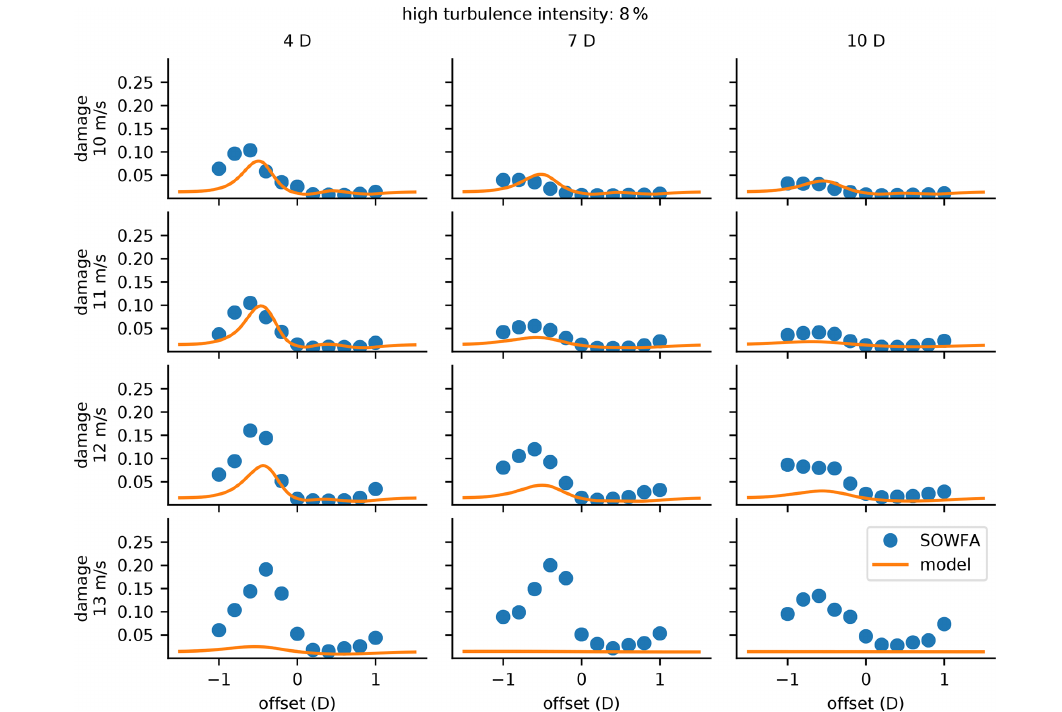
Figure 11. Comparison of our presented damage model to the lifetime damage predicted by the loads from the SOWFA and OpenFAST data. This figure is for a high freestream turbulence intensity of 8%. From top to bottom, each row represents different freestream wind speeds of 10, 11, 12, and 13ms − 1 . From left to right, each column represents different distances from the upstream turbine of 4, 7, and 10 D .